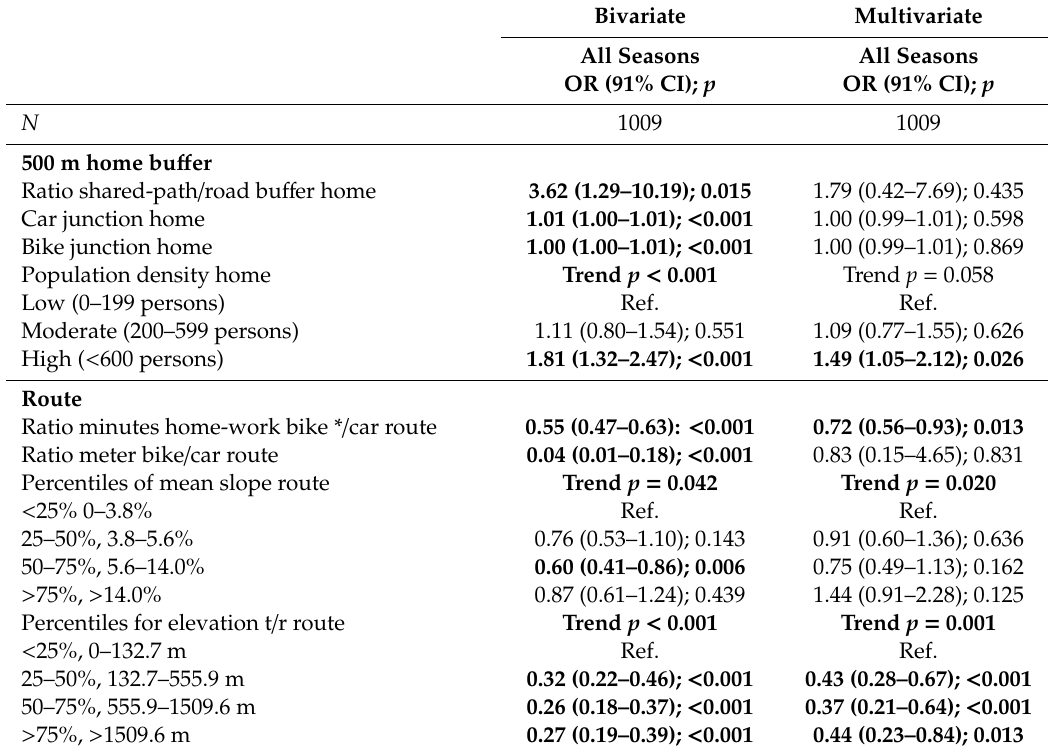
Table 3. Likelihood of being a cyclist. Environmental factors (GIS data). n = 1009. Presented as bivariate and multivariate analyses. Significant associations are written in